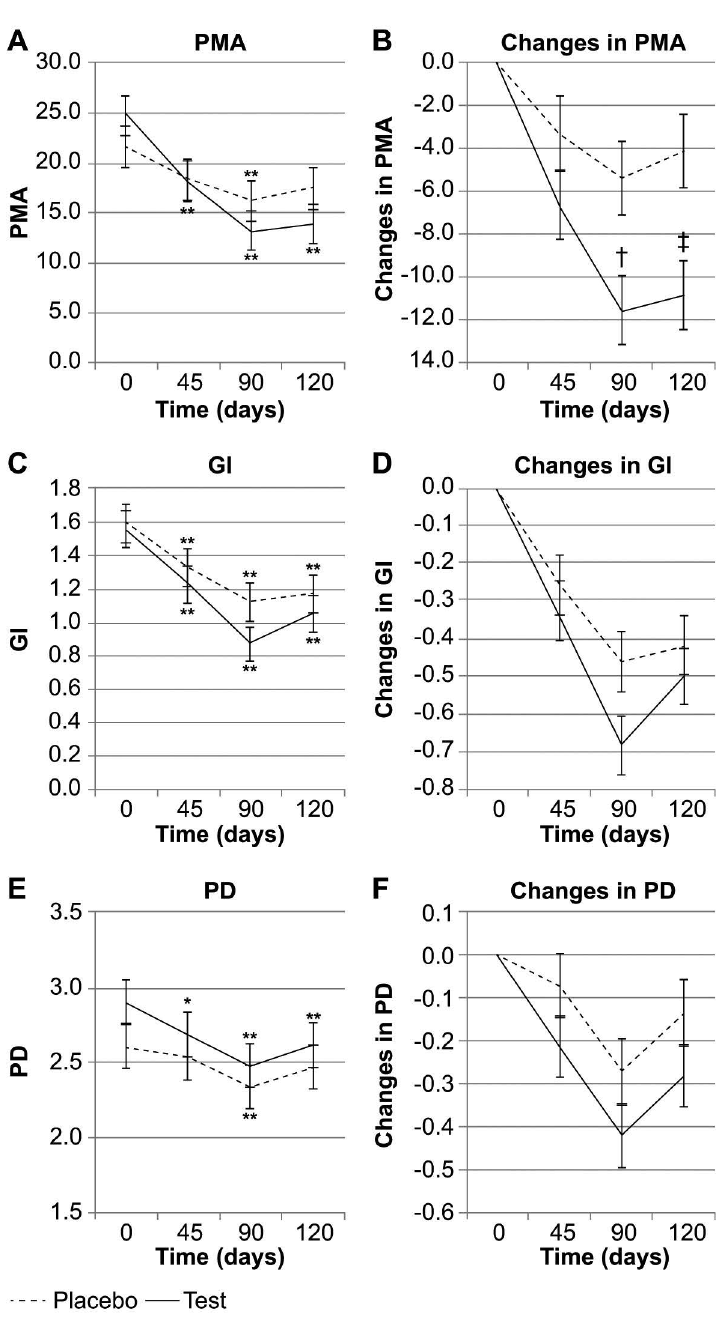
Figure 2- Mean values and magnitude of change in each clinical parameter for individuals with intellectual disability who consumed L8020 yogurt (bovine milk fermented with Lactobacillus rhamnosus L8020; test group) or a conventionally prepared commercial yogurt (placebo group). (A) Mean PMA index scores at baseline, after 45 and 90 days of continuous daily yogurt consumption, and 30 days after the cessation of yogurt consumption (120 days after the start of consumption); (B) The magnitude of change in the PMA index score from baseline to 90 days and from baseline to 120 days is significantly greater in the test group than in the placebo group (p = 0.006); (C) Mean GI scores at baseline, after 45 and 90 days of continuous daily yogurt consumption, and 30 days after cessation of yogurt consumption; (D) Magnitude of change in the GI score from baseline to 90 days and from baseline to 120 days; (E) Mean PD values at baseline, after 45 and 90 days of continuous daily yogurt consumption, and 30 days after cessation of yogurt consumption; (F) The magnitude of change in PD from baseline to 90 days and from baseline to 120 days. GI, gingival index; PD, probing depth; PMA,